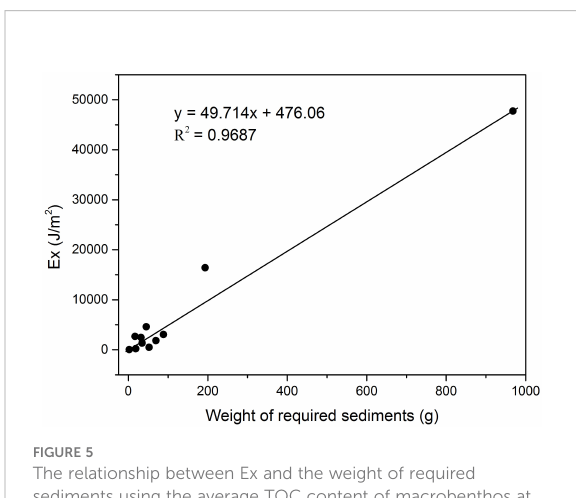
FIGURE 5 The relationship between Ex and the weight of required sediments using the average TOC content of macrobenthos at the 11 sampling sites.